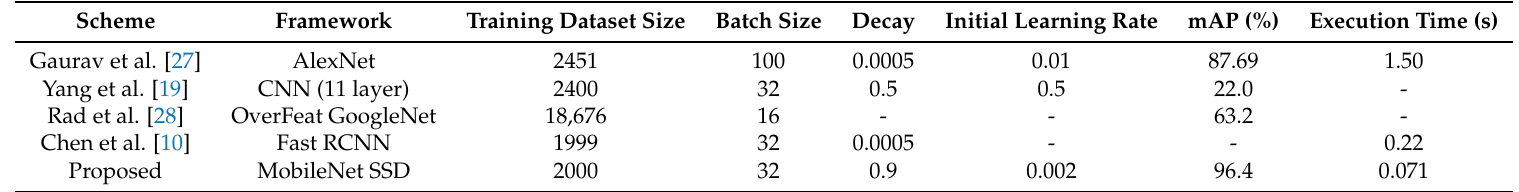
Table 5. Comparison with Similar Schemes.